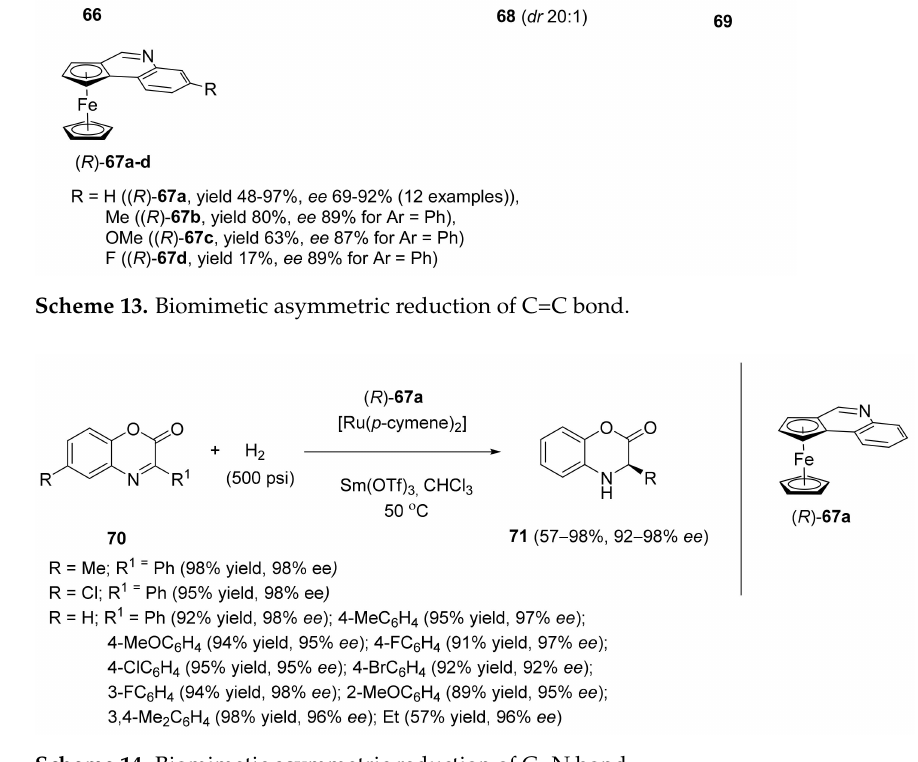
Scheme 14. Biomimetic asymmetric reduction of C=N